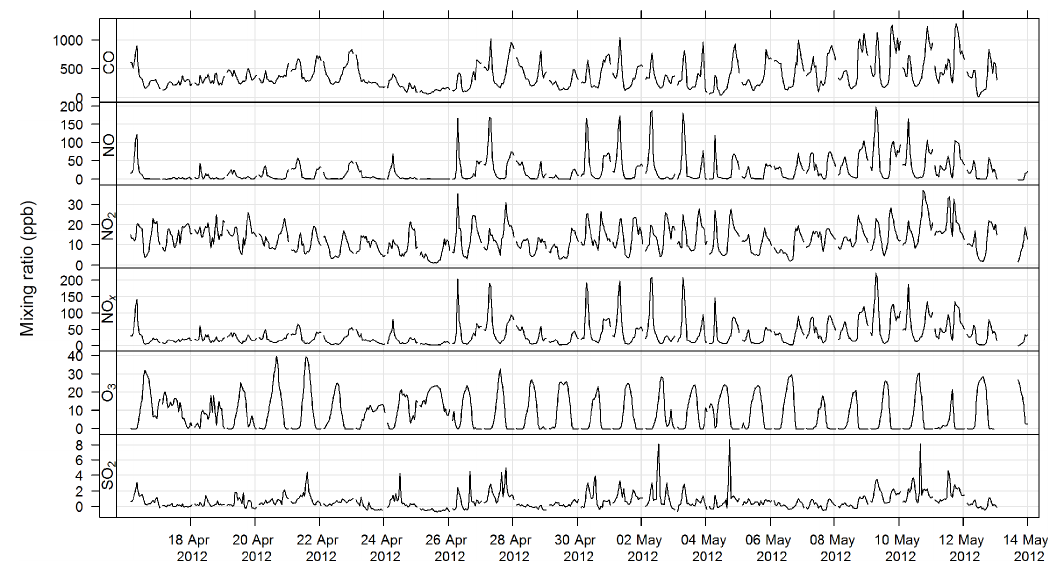
Figure 8. Time series of hourly averaged mixing ratios of criteria gases CO, NO, NO 2 , NO x , O 3 , and SO 2 during SPS-II.